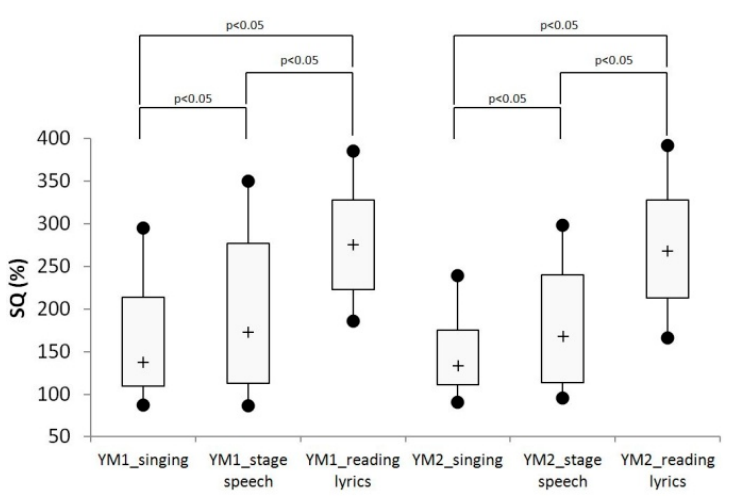
Figure 4. Box plot of SQ.